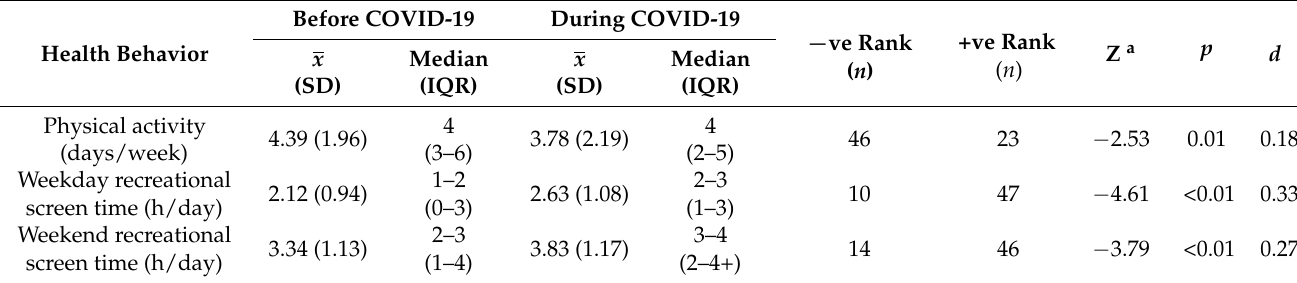
Table 2. Changes in children’s physical activity and screen time from before to during COVID-19 ( n = 95).